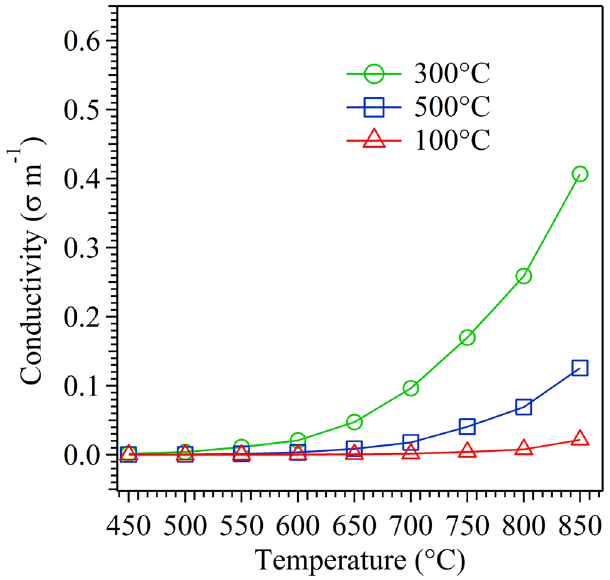
Figure 13. Conductivity of SDC thin film electrolyte as a function of temperature with respect to the substrate